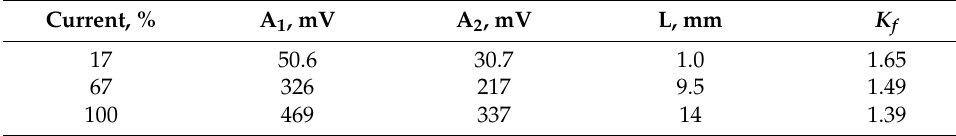
Figure 24. VA signal spectra for two frequency ranges for the initial and final stages of IN23 ceramics processing: ( a ) low frequency range; ( b ) high frequency range. Table 1. Parameters of VA signals for EDM of low-carbon steel.